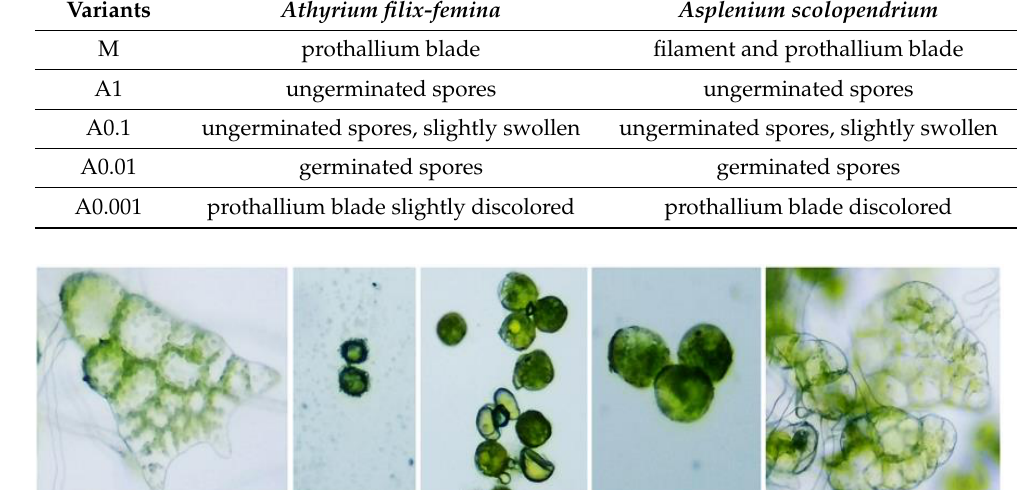
Table 4. Influence of Actellic 50 EC on gametophyte differentiation.